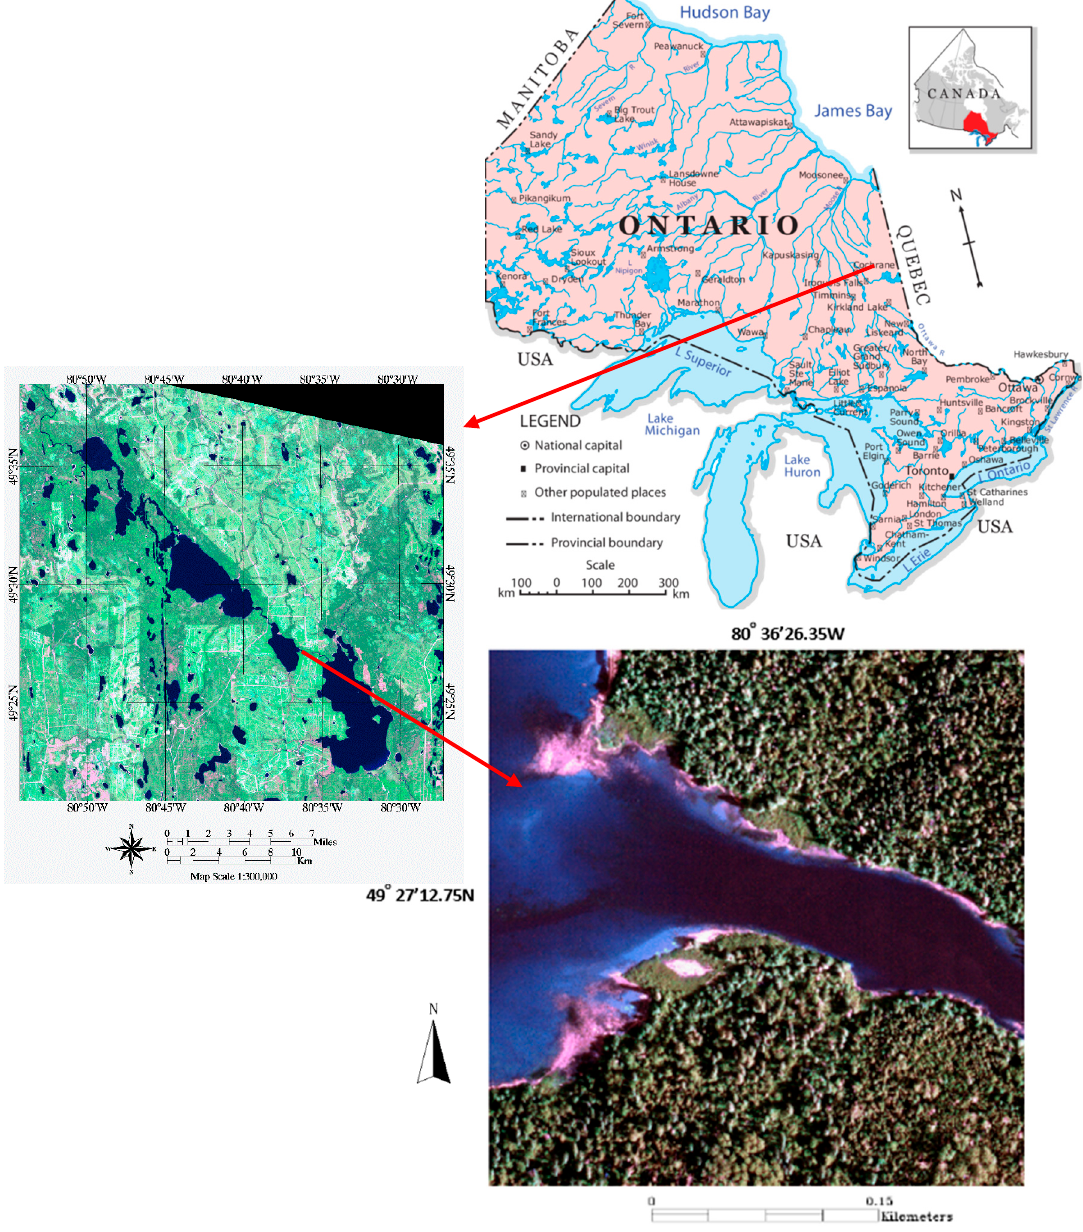
Figure 1. The study area from a geographic perspective, and from Landsat-5 and from aerial imagery. Landsat-5, RADARSAT-2, and Sentinel-1 imagery were the primary image sources used in this study. The Landsat-5 series of sensors collect multispectral optical imagery with a spatial resolution of Table 1. Summary of remotely-sensed imagery collected for this study. 30 m by 30 m and thermal imagery at 120 m by 120 m [35]. As a point to note, when creating layer stacks of these images for analysis, the lower resolution (120 m by 120 m) temperature-based images were resampled to 30 m by 30